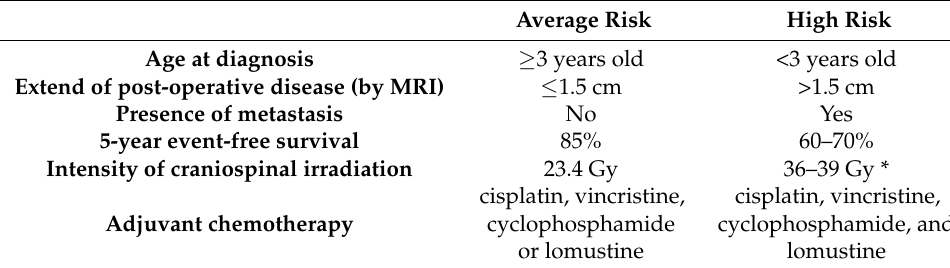
Table 2. Patient risk